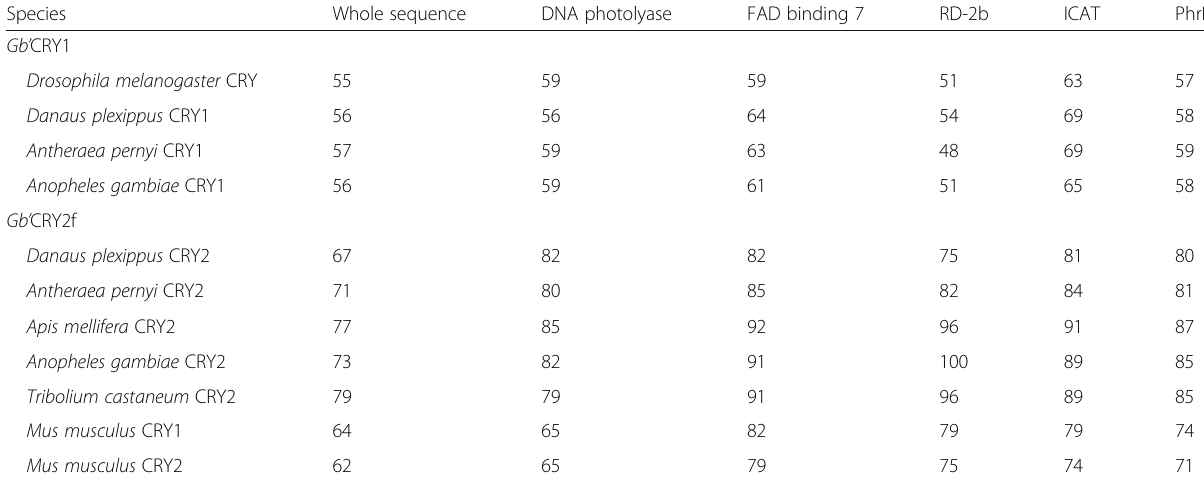
Table 2 Overall amino acid identity (%) of whole sequence and functional domains of Gryllus bimaculatus CRY1 and CRY2f with their insect and mammalian orthologues